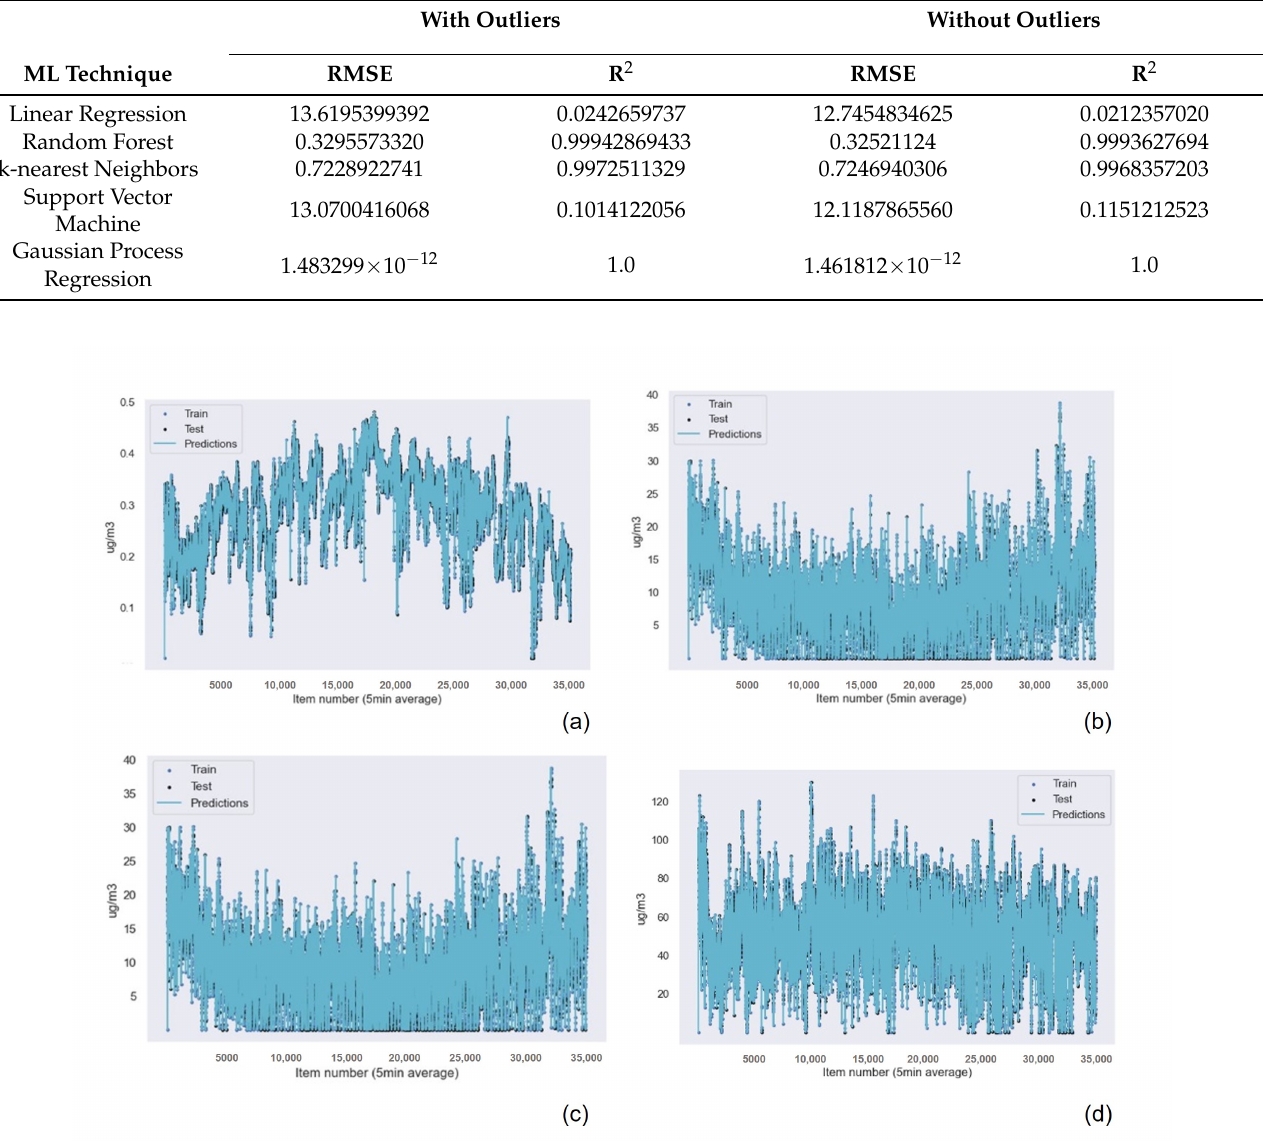
Table 11. Humidity results.